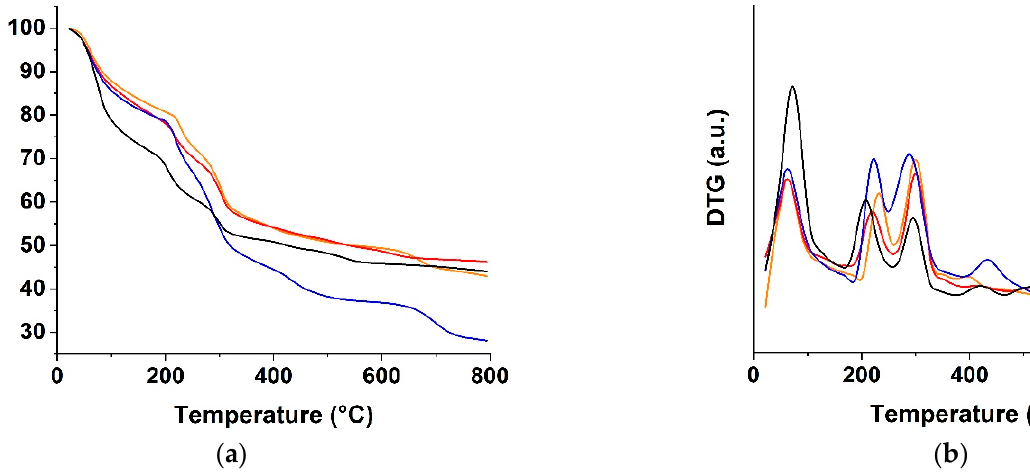
Figure 4. ( a ) TGA and ( b ) DTG curves of H ALG (blue lines), H ALG-GO (black lines), CUR@H ALG (red lines), and CUR@H ALG-GO (orange lines).